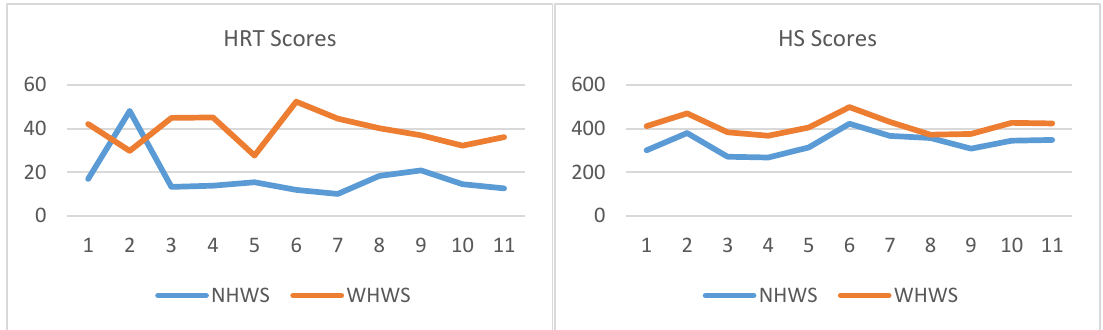
Figure 4. Participants’ mean HRT and HS scores across all missions and hazard types.